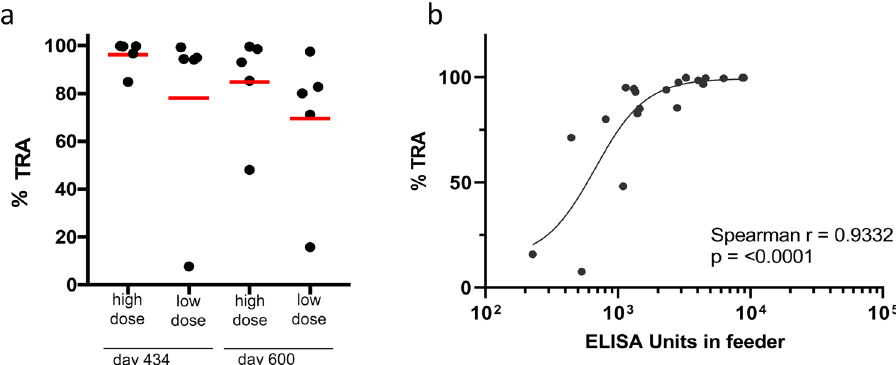
Fig. 4 A third vaccination of Pfs230D1-EPA induces durable functional activity. a transmission reducing activity, by group, 16 weeks (d434) and 40 weeks (d600) after 3rd vaccination. Each data point represents TRA from one monkey; red lines denote arithmetic mean TRA. b nonlinear 4-parameter curve fi t of log (titer) vs TRA. Antibody titers shown account for dilution of immune monkey sera in the feeding assay. An IC50 was estimated for using a 4-parameter curve fi t of the log(titer) vs %TRA for each monkey of the d434 and d600 SMFA data combined.